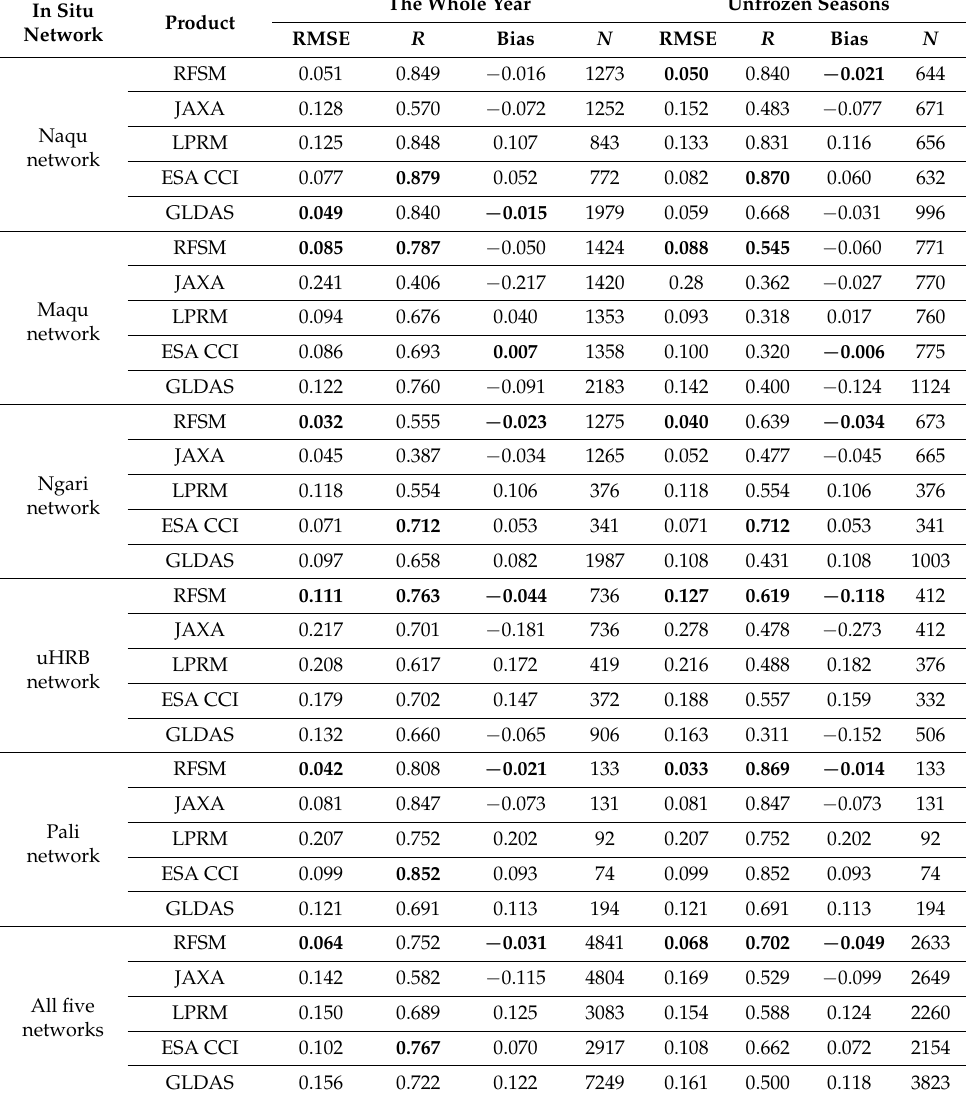
Table 4. The performance metrics for random forest soil moisture (RFSM), Japan Aerospace Exploration Agency (JAXA), land surface parameter model (LPRM), European Space Agency’s Climate Change Initiative (ESA CCI) and Global Land Data Assimilation System (GLDAS) soil moisture (SM) data over the five networks from 1 January 2010 to 31 December 2015. Bold numbers indicate the best performance of root mean square error (RMSE), correlation coefficient ( R ) and bias. The value N indicates the number of data points that can be used to validate RFSM over the five